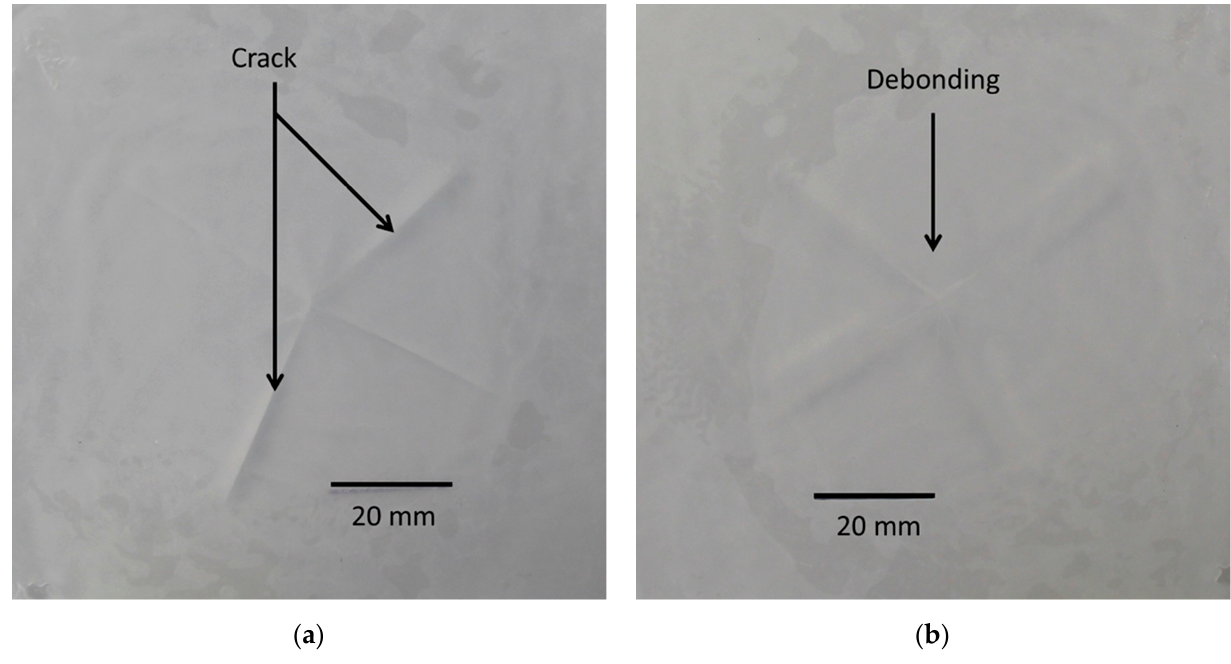
Figure 8 . Layered PMMA specimen at 12 J impact energy ( a ) top layer and ( b ) bottom layer. Figure 8. Layered PMMA specimen at 12 J impact energy ( a ) top layer and ( b ) bottom